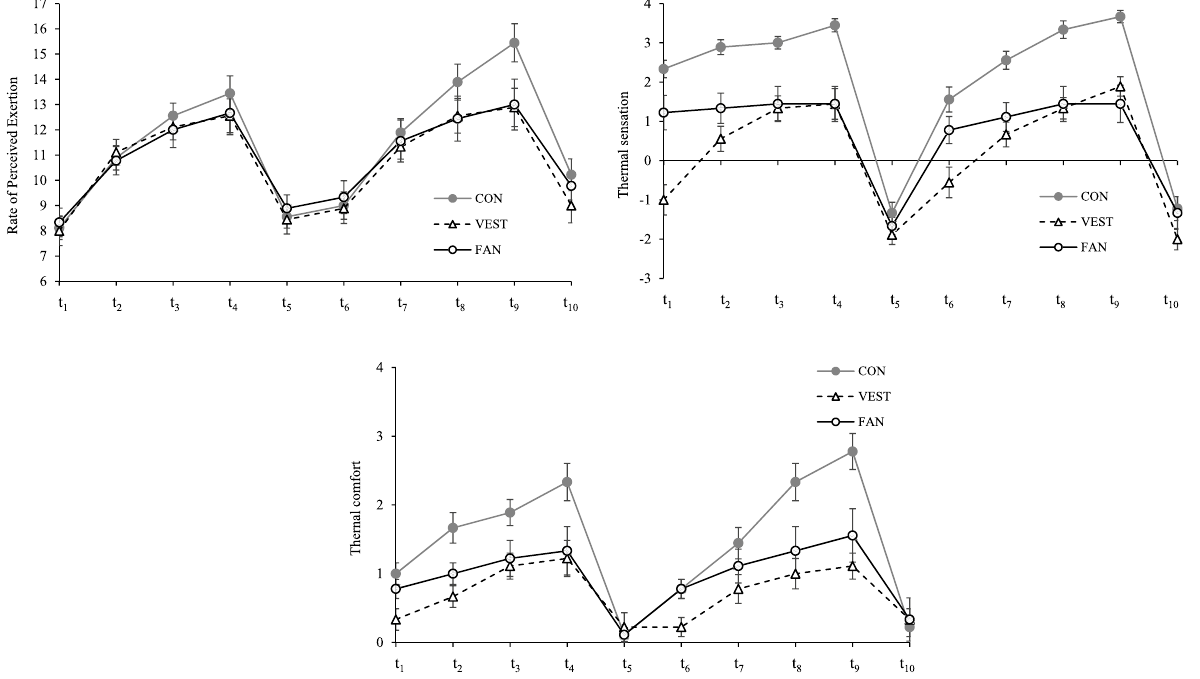
Figure 4. ( a ) Rate of perceived exertion in the CON, VEST, and FAN conditions. ( b ) Thermal sensation in the CON, VEST, and FAN conditions. ( c ) Thermal comfort in the CON, VEST, and FAN conditions. Data at every time points are presented as the mean ± standard error. CON participants did not wear any cooling garment, VEST participants wore a circulating-water cooling vest, FAN participants wore a fan-attached jacket. t 1 and t 6 : immediately before starting exercise; t 2 –t 4 and t 7 –t 9 : 10, 20, and 30 min, respectively, after starting exercise; t 5 and t 10 : during rest. Number of participants: